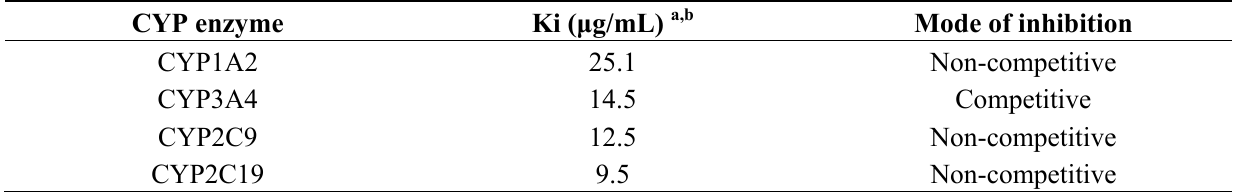
Table 3. Inhibition constant (Ki) and modes of inhibition for B. monnieri extract on the activities of human CYP